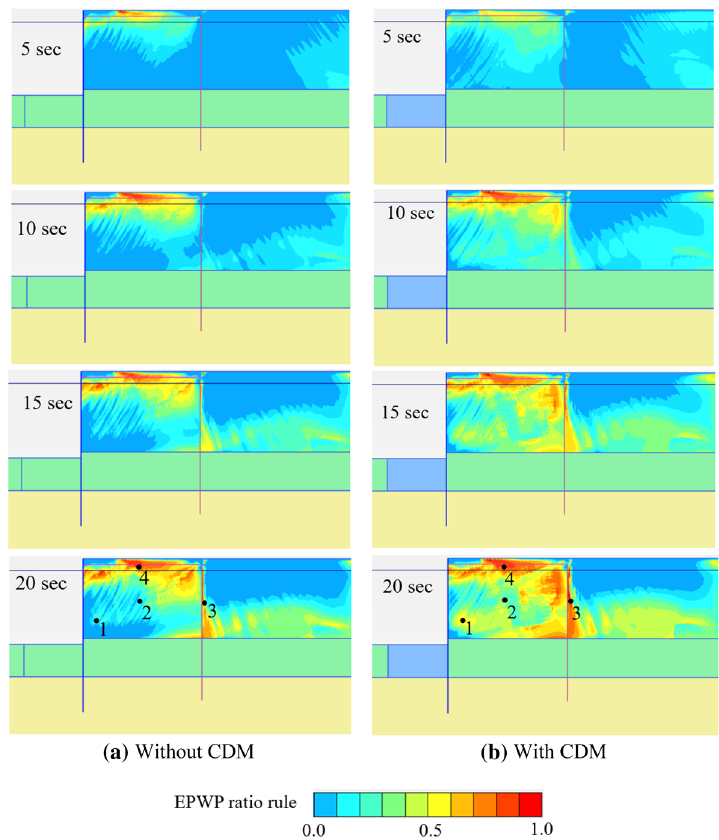
Figure 10a, b plot the horizontal displacement and bending moment of the sheet pile wall along with the depth at the end of five earthquake motions, respectively. It is evi- dent that the deformed shape of the sheet pile and the distribution of bending moment did not affect by the excitation characteristics. Both maximum horizontal displace- ment and bending moment occurred at level around 8 m from the surface. The maxi- mum displacements and displacements at the top of the sheet pile obtained from five earthquake motions are listed in Table 5. The maximum displacement ranged from 13.96 to 17.17 cm, and displacement at the pile top from 9.95 to 12.45 cm. Similarly, Table 6 shows the maximum bending moments of the sheet pile under five earthquake